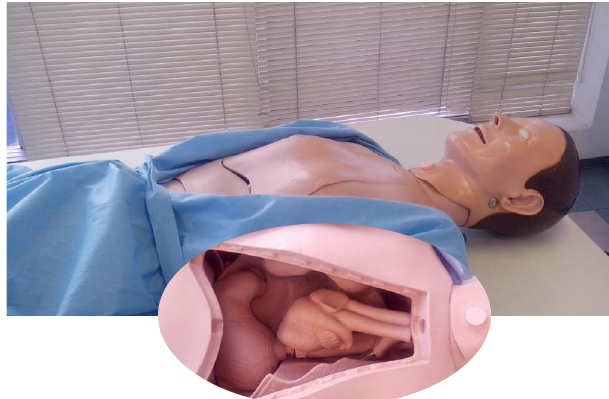
Fig. 5 - Dummy with removable chest wall. Highlighted, view from inside the chest cavity molds with viscera of the chest and upper abdomen.